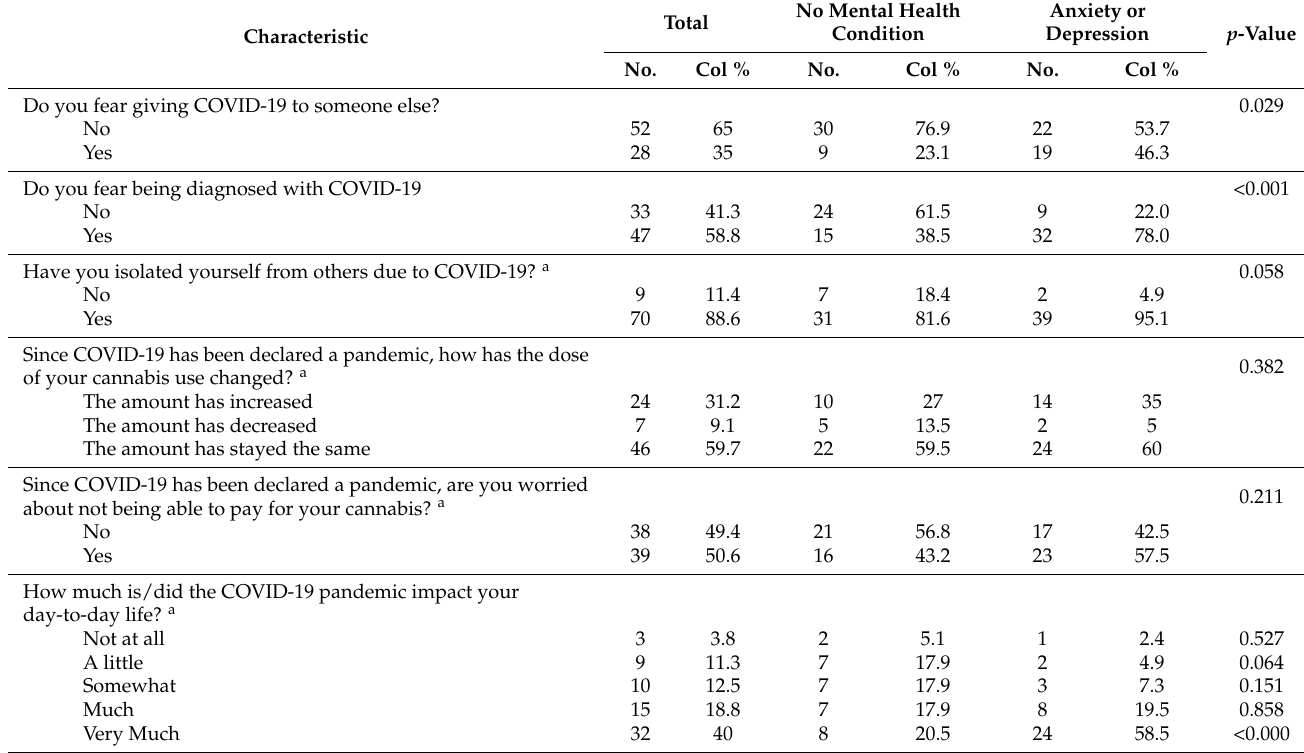
Table 4. Impact of the pandemic on behaviors among cancer survivors who endorse cannabis by mental health condition ( n =